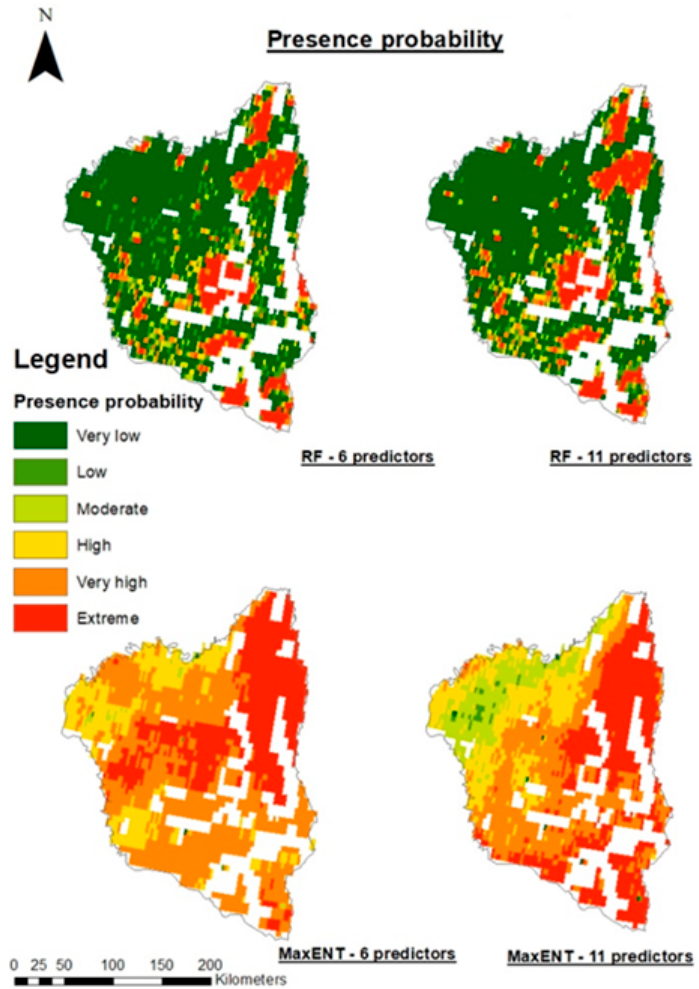
Figure 6. Results of the long-term wildfire presence probability modeling in Nyurbinksy (microscale).